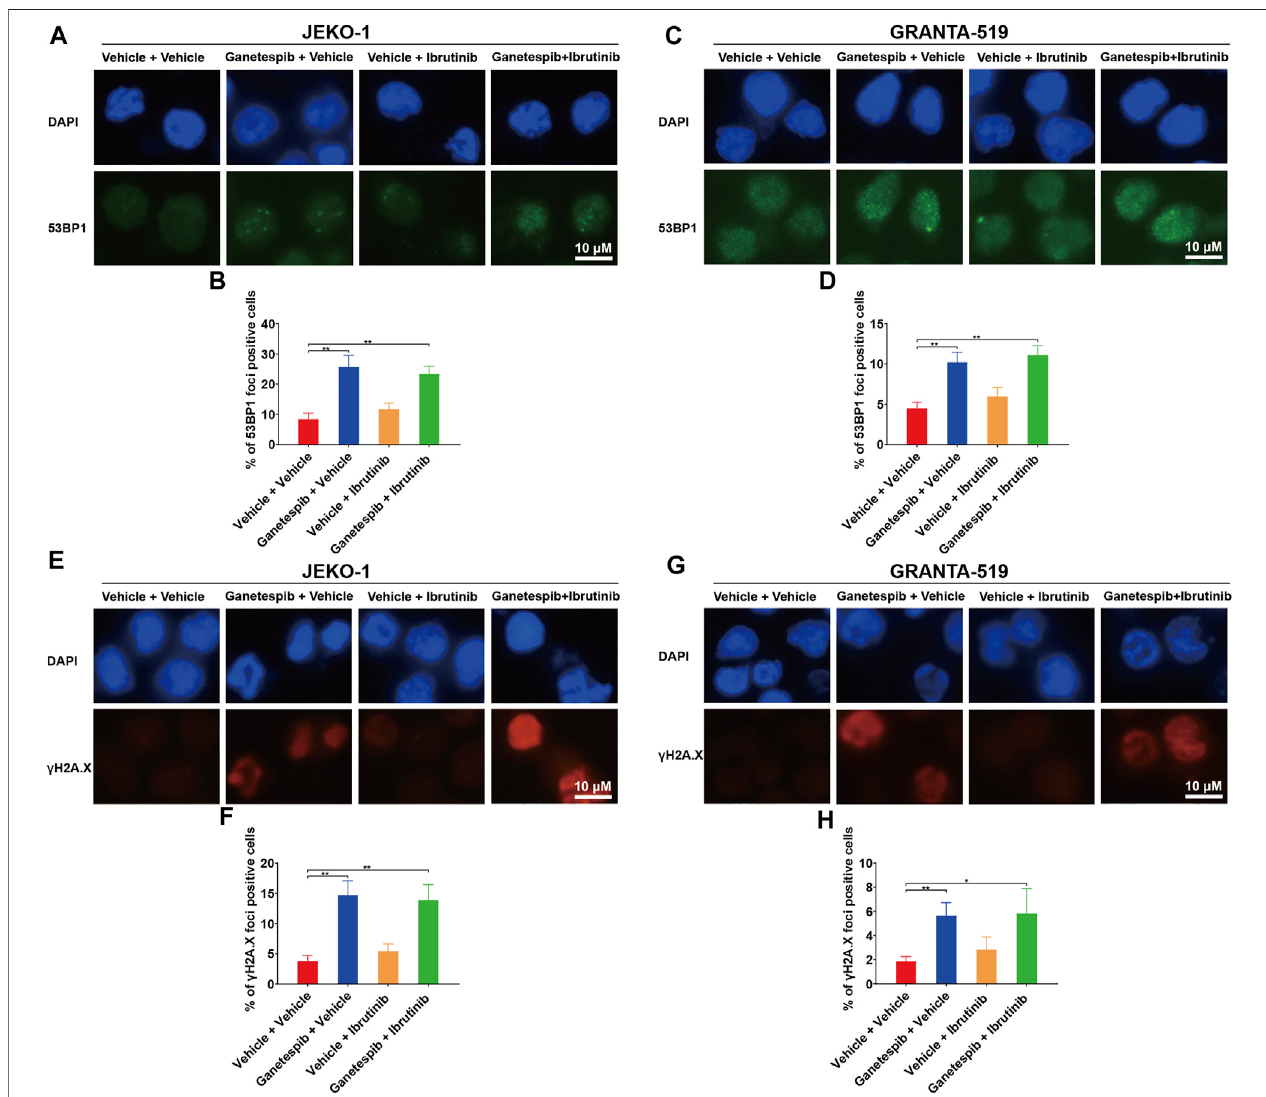
FIGURE 3 | Effects of combination therapy on DNA damage. Jeko-1 and Granta-519 cells were treated with ganetespib (15 nM for Jeko-1 and 45 nM for Granta- 519 cells, respectively) for 12 h, and then treated with either ibrutinib at 6 μ M or vehicle for 60 h. (A – D) Representative pictures and statistics of immuno fl uorescence of 53BP1in Jeko-1 (A,B) and Granta-519cells (C,D) . (E – H) Representative pictures and statistics ofimmuno fl uorescence of γ H2AX in Jeko-1 (E,F) and Granta-519 cells (G,H) . Mean ± SD, n = 3.